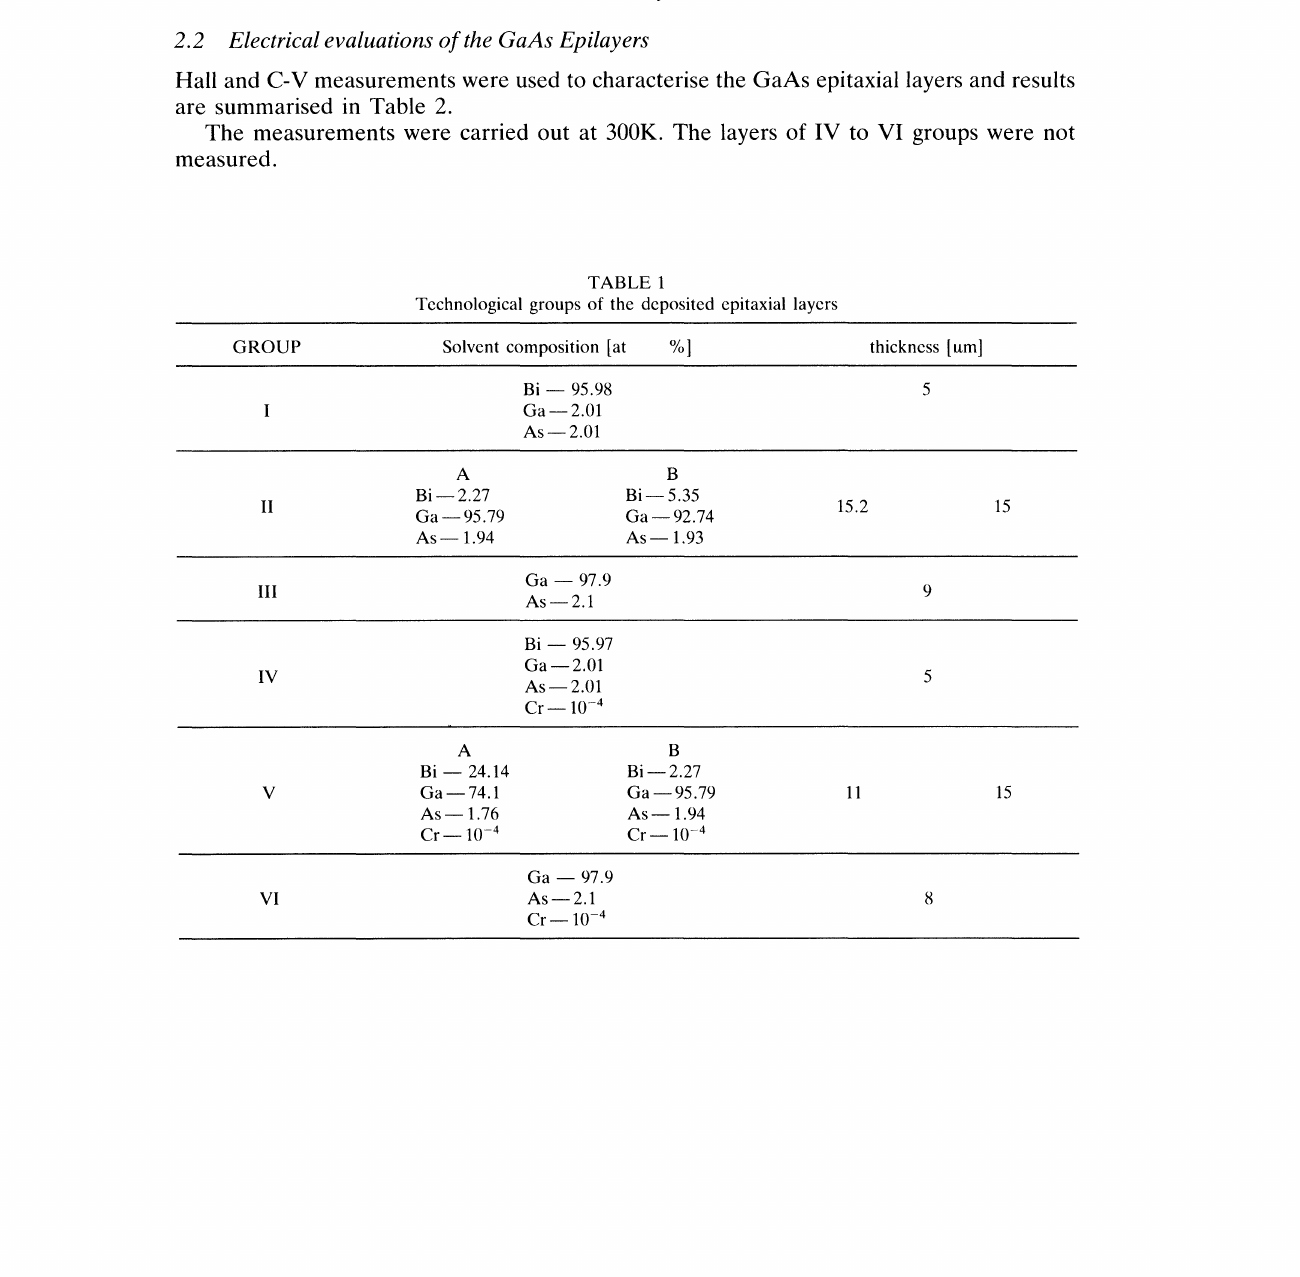
TABLE Technological groups of the deposited epitaxial